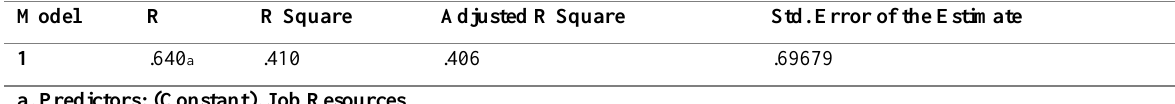
Table 2: Model summary for job resources on work engagement